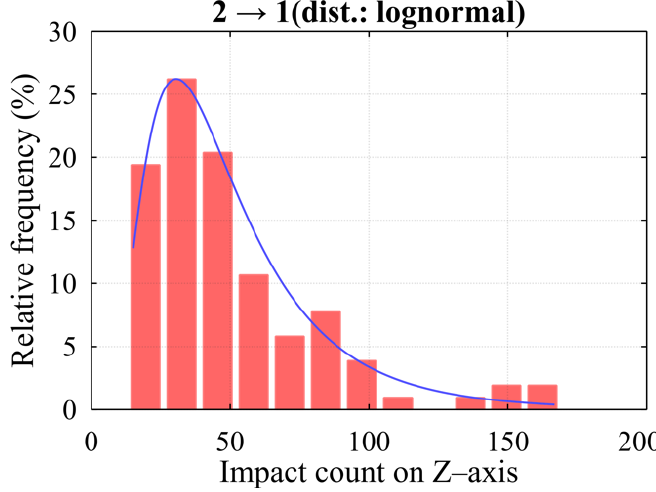
Figure 26. Histogram of potential impacts (events).